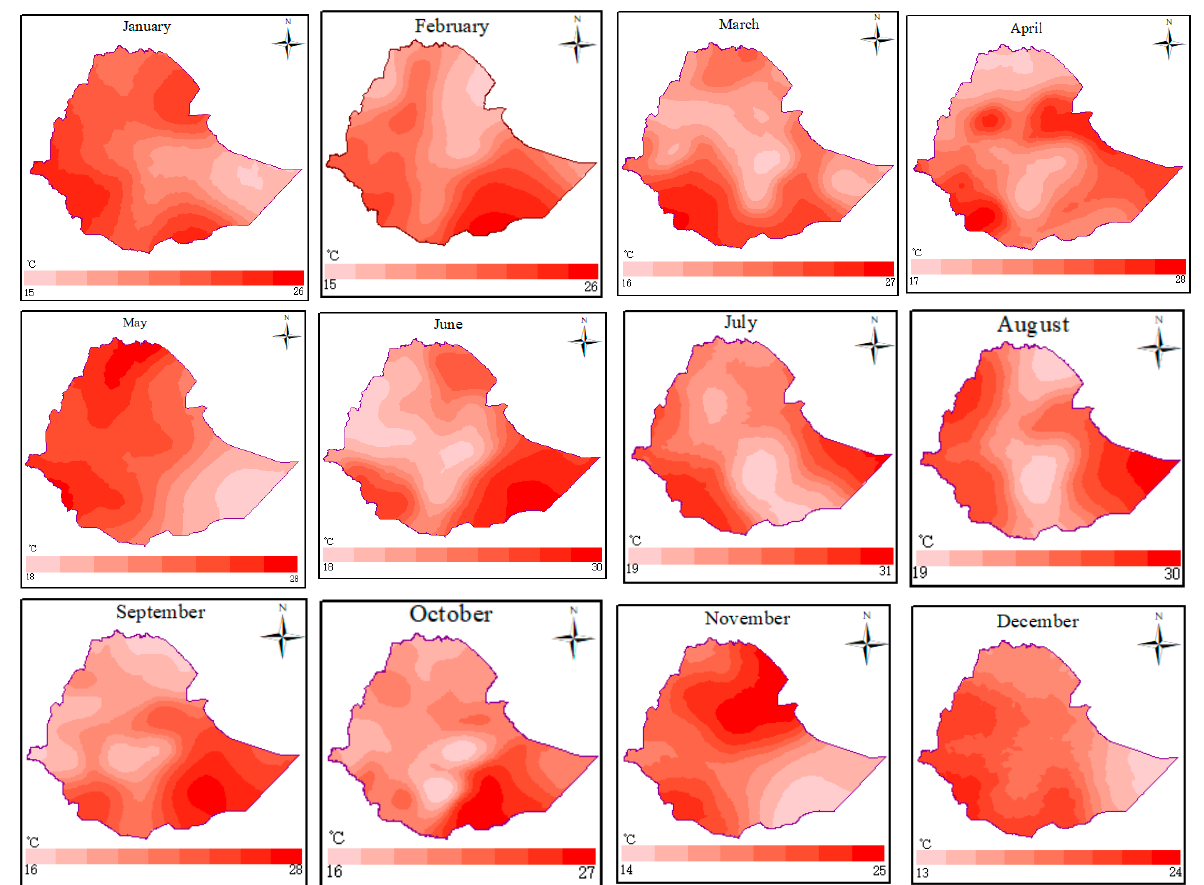
Figure 7. High-resolution maps of the mean monthly air temperature in Ethiopia during 1990–2020 generated using the hybrid of MLPs.